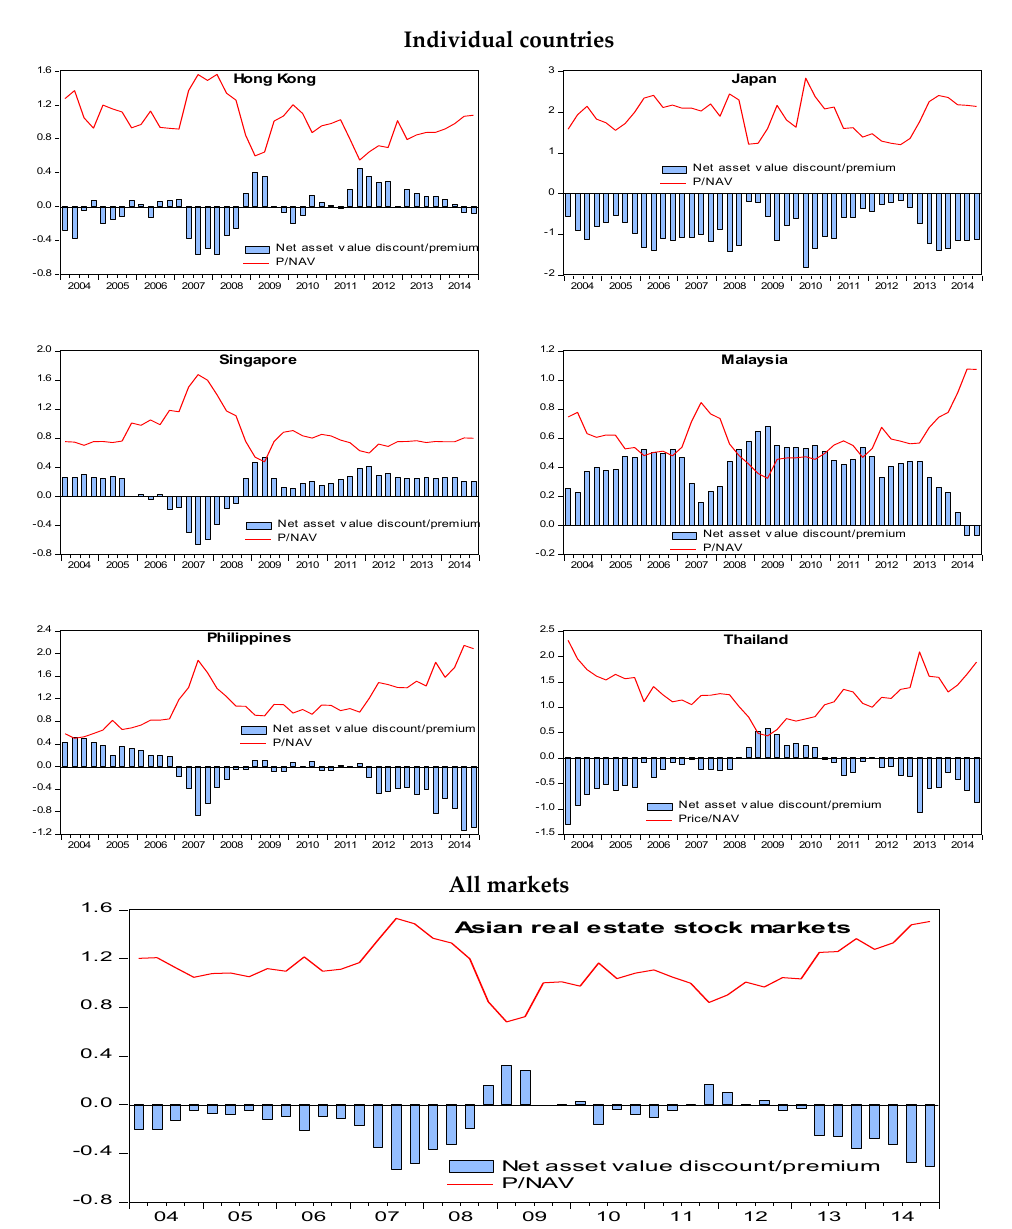
Figure 1. Net asset value discount/premium and P/NAV of Asian real estate companies. Overall, the above results agree with the closed-end fund literature that prices fluctuate from NAVs. While the average real estate stocks’ NAV premiums or discounts detected may indicate a form of investor sentiment (which is a function of the market condition) regarding the “growth” potential of Asian public real estate markets (Barkham and Ward 1999), there are many potential